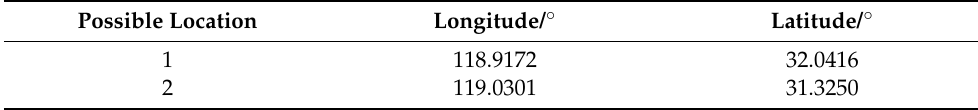
Table 7. Optimized locations with 50 km rescue